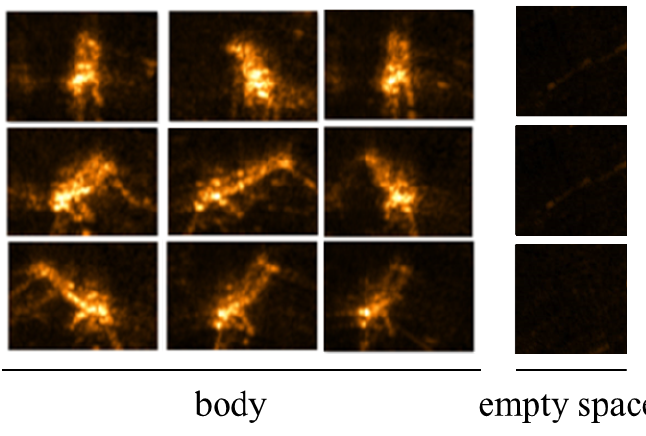
Figure 7. CKI samples including human body and empty space.